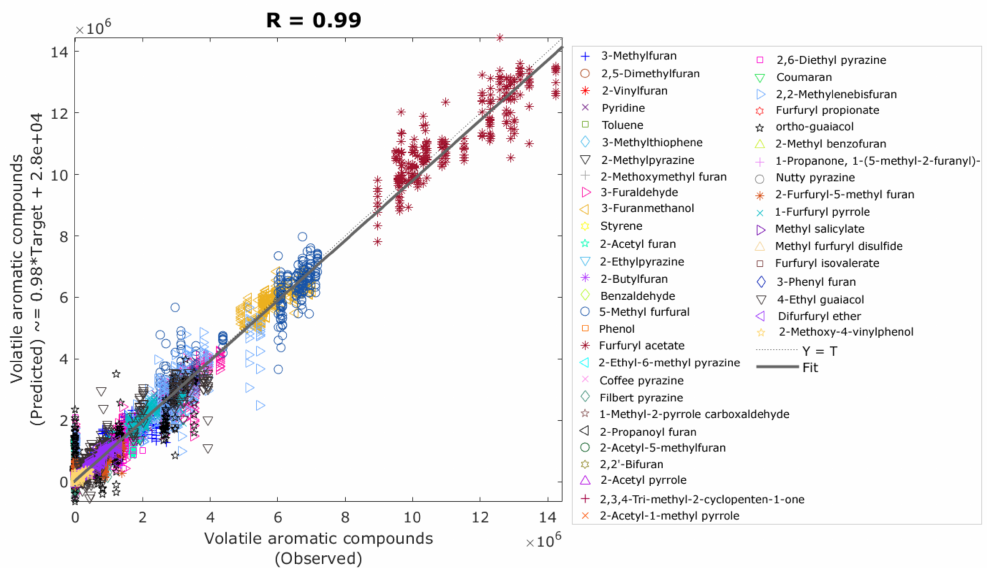
Figure 7. Overall artificial neural network regression model showing the observed (x-axis) and predicted (y-axis) values of the peak area of the volatile aromatic compounds (Model 2). Abbreviations: R: correlation coefficient, T: